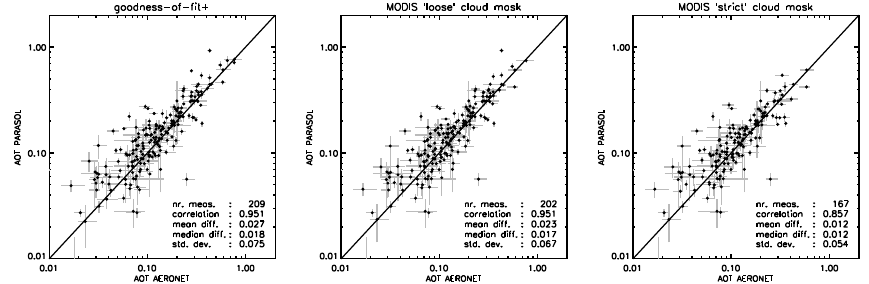
Figure 9. A comparison of the AOTs retrieved from the full-resolution PARASOL observations vs. those retrieved by AERONET (level 2.0) for the three different cloud screenings. The black line shows the 1 : 1 ratio.